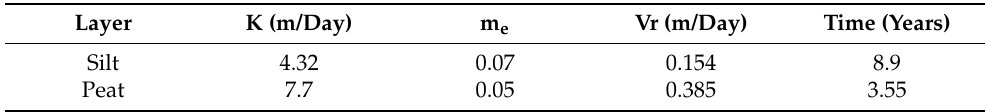
Table 2. Estimation of transit time in organic silt and peat layers of quaternary aquifer of Á greda. K, hydraulic conductivity; m e, effective porosity; V r , average linear velocity. Layer K